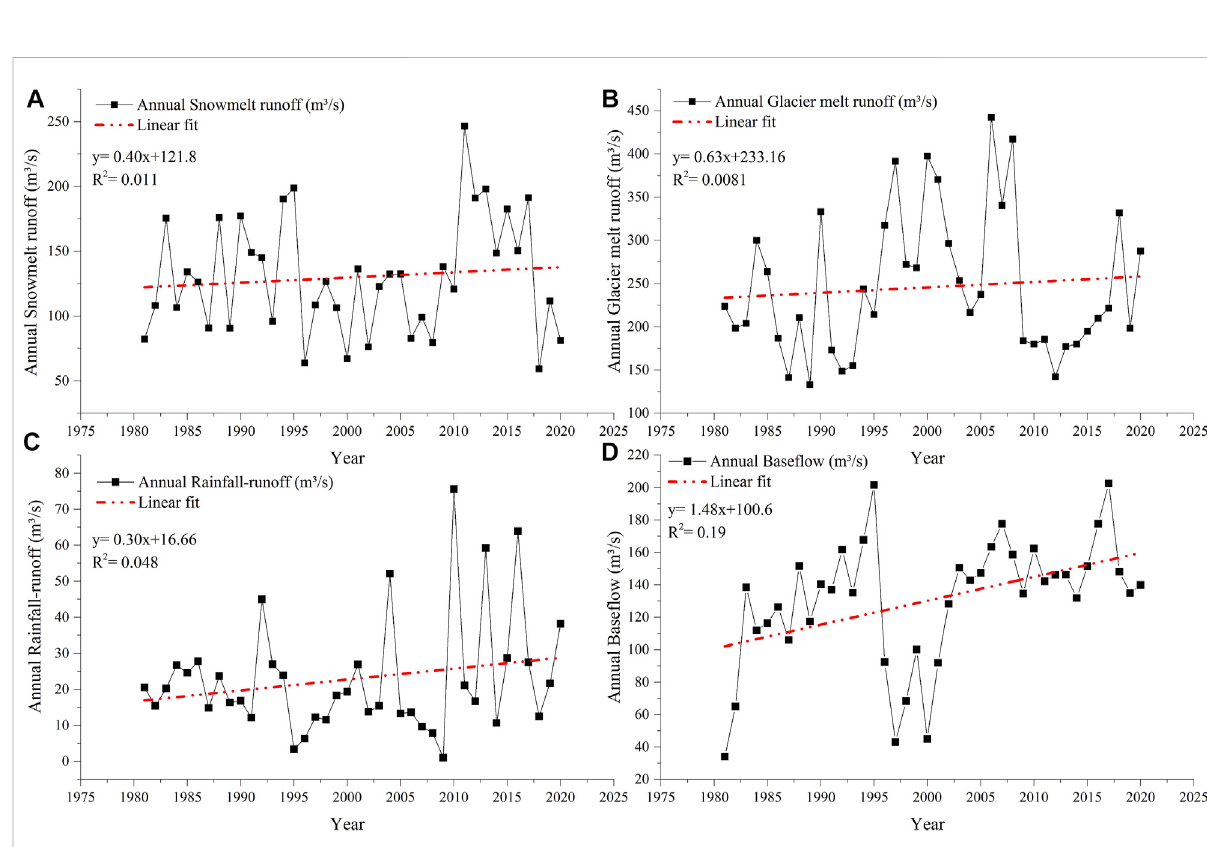
FIGURE 7 Temporal variations in simulated runoff components of Gilgit River from 1981 to